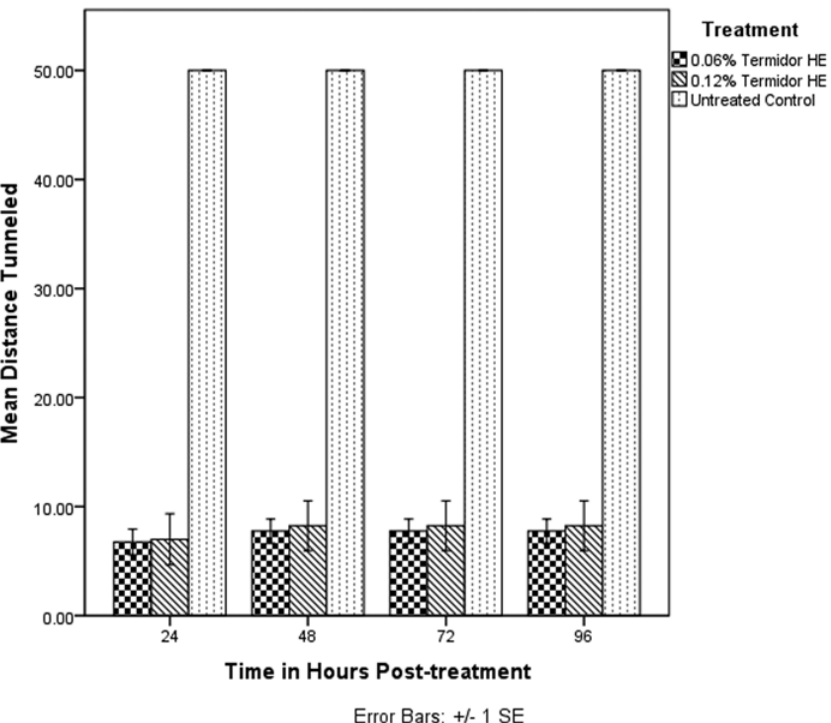
Fig. 5. Mean distance tunneled (mm) by Reticulitermes flavipes in a glass tube bioassay through time in soils treated with Termidor ® HE (maximum distance tunneled could not exceed 50